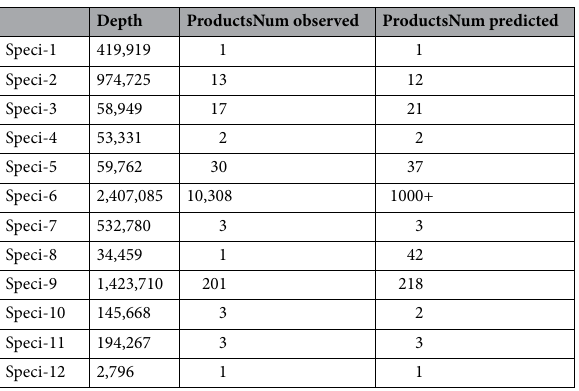
Table 2. Comparison of the number of products observed in NGS and predicted by PrimerScore2 in the 12-plex